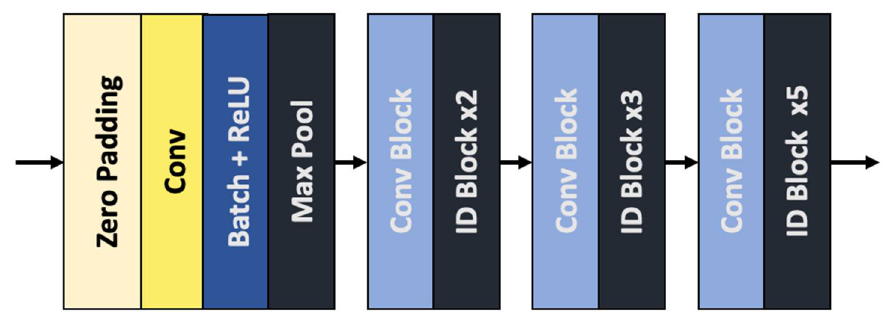
Figure 2. The layers of the ResNet-50 encoder.